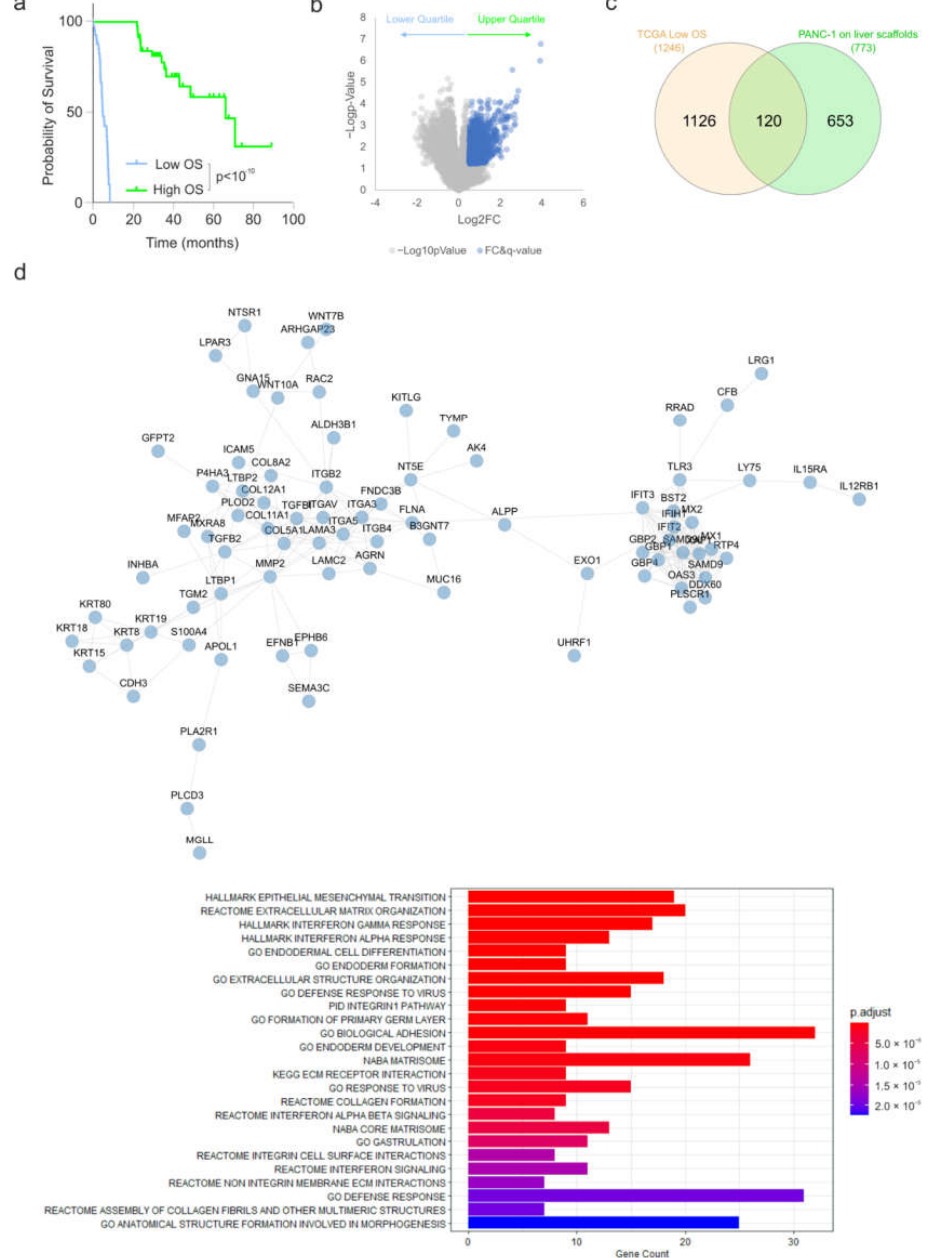
Figure 3. Identification of genes induced in PANC1 cells on liver scaffolds and those associated with clinically aggressive PDAC. ( a ) Overall survival (OS) of the upper and lower quartiles of 184 PDAC patients from the TCGA PanCancer Atlas (cBioPortal). ( b ) Volcano plot of gene expression for patient tumours in the upper and lower quartiles for overall survival from ( a ). Genes highlighted in blue indicate those showing significantly increased expression (LFC > 0.5, q-value < 0.25). ( c ) Overlap analysis of genes increased in PANC-1 cells on the liver scaffold compared to the pancreas scaffold and those increased in the tumours of patients displaying poor survival. ( d ) STRING interaction network for the 120 genes identified in the overlap analysis. Functional enrichment analysis of the 120 genes identified in the overlap analysis is presented. Bar length is analogous to the number of differentially expressed genes in the functional annotation category, while the bar color depicts the adjusted p -value for the hypergeometric test